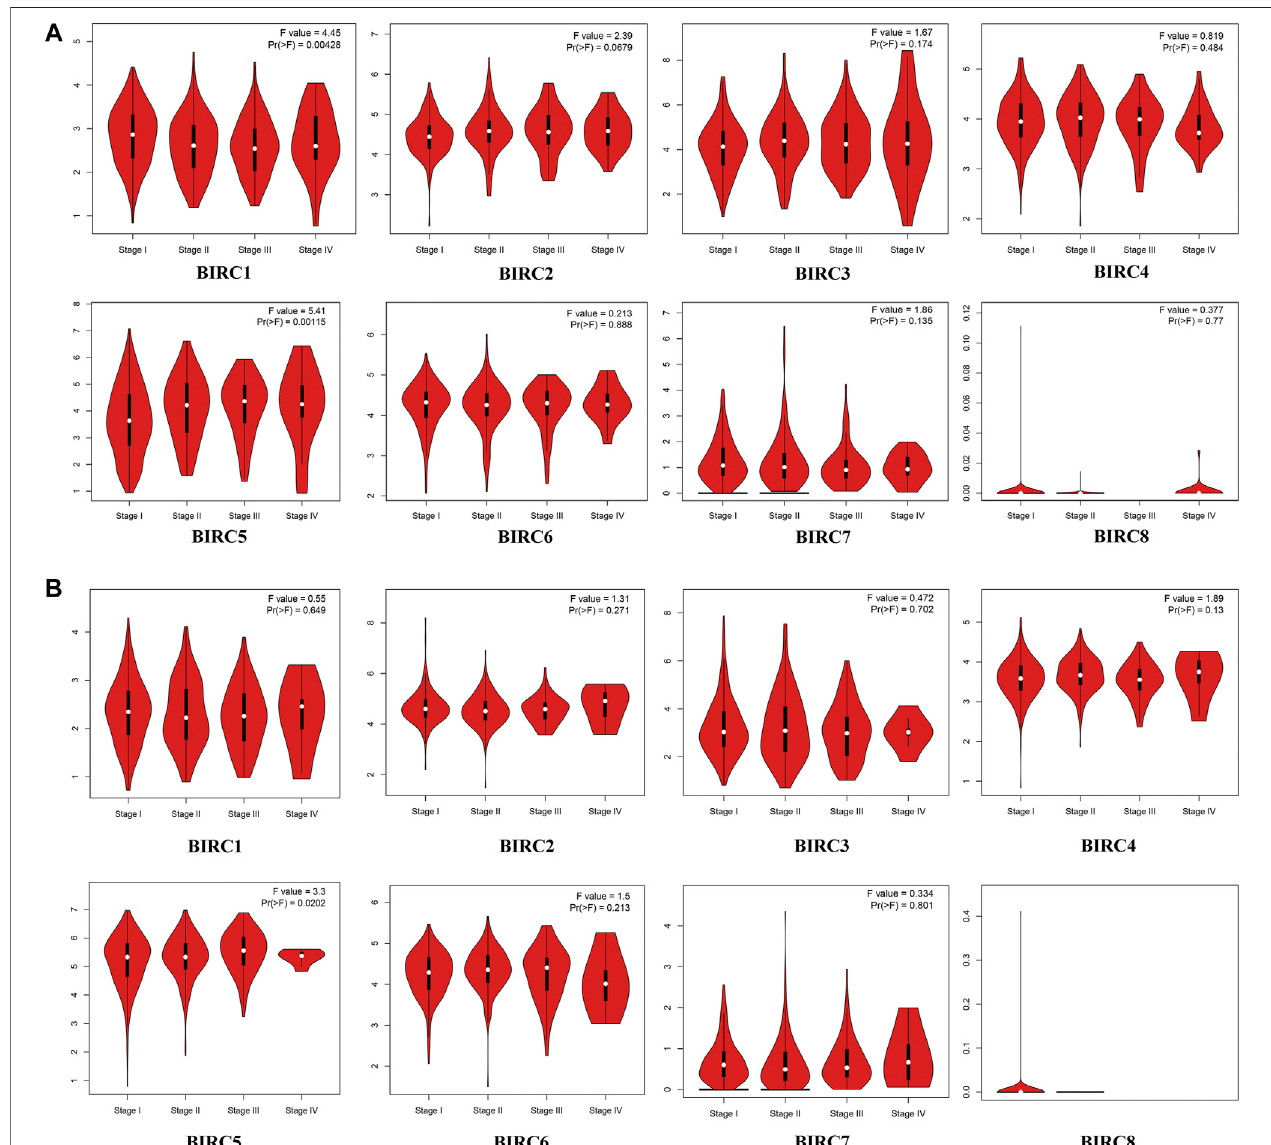
FIGURE 2 | mRNA Expression of IAPs in Different Stages of NSCLC. (A) Correlation between mRNA expression of IAPs and tumor stage in LUAD patients. (B) CorrelationbetweenmRNAexpressionofIAPsandtumorstageinLUSCPatients. Pr < 0.05indicatesthatthegeneexpressiondiffersacrossstages.NSCLC,non – small cell lung cancer; LUAD, lung adenocarcinoma; LUSC, lung squamous cell